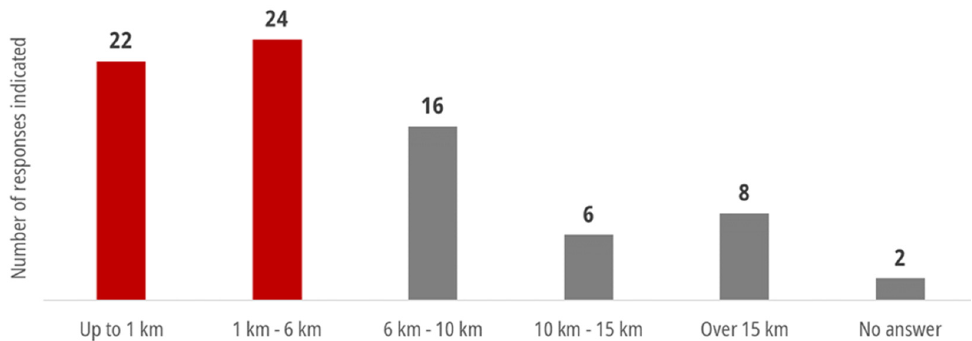
Figure A11. Responses to question (15).